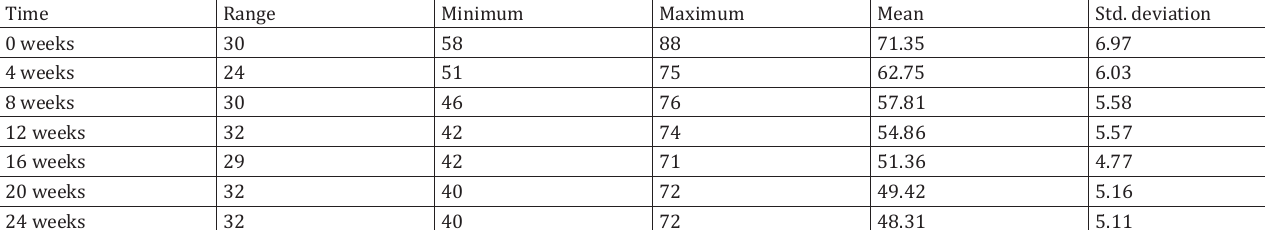
Mean DASH score dramatically decreased from 71.35 to 48.31